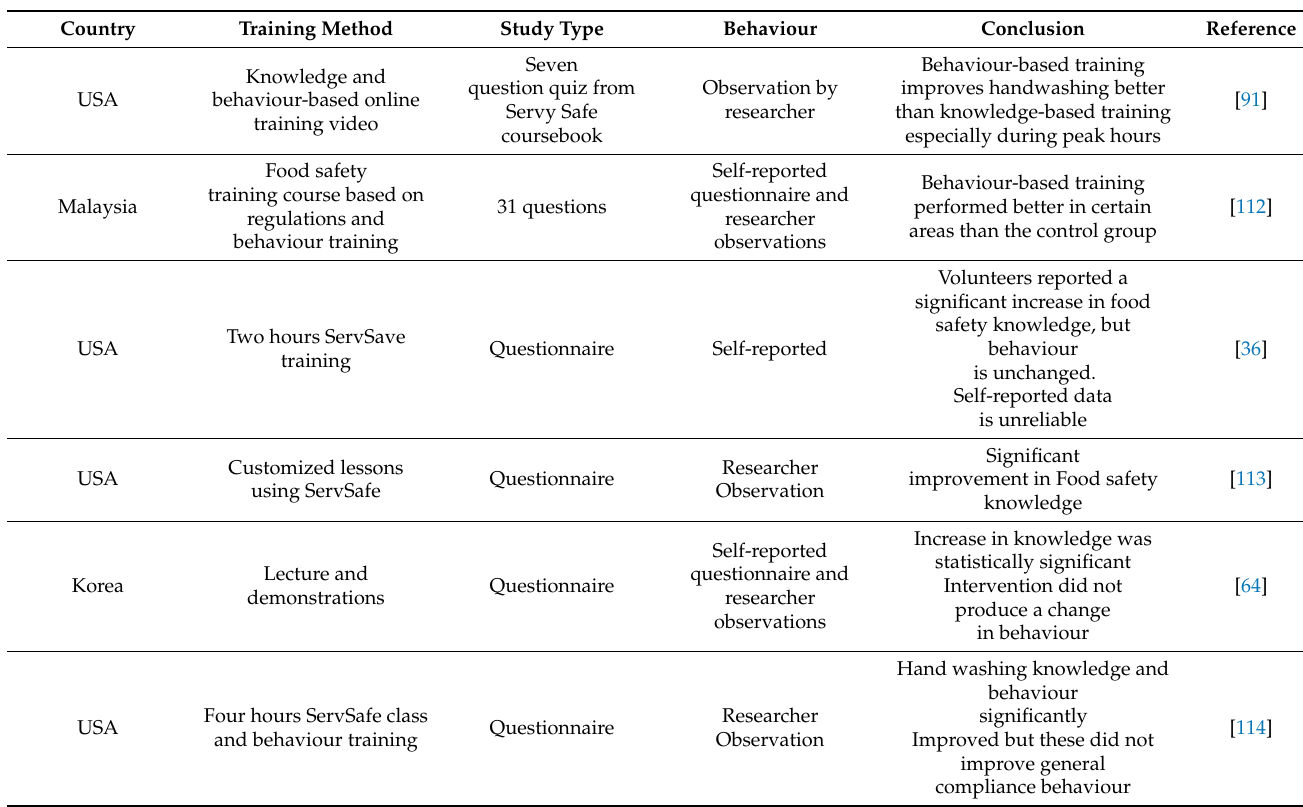
Table 9. A comparison of food safety training